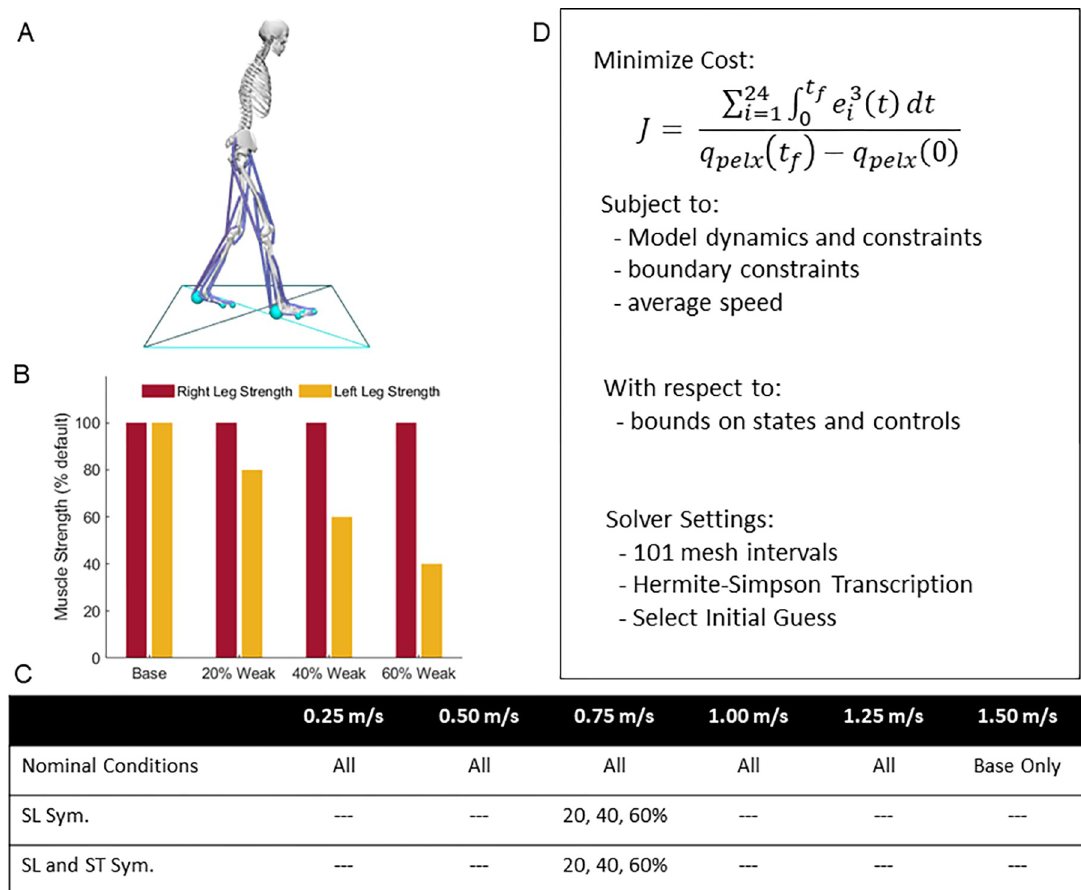
Fig 1. Summary of set up. A) Two-dimensional musculoskeletal model with 11 mechanical degrees-of-freedom and 24 muscle-tendon units [86]. Blue spheres represent foot-contact elements on the model with the blue box visually representing the floor. B) Maximum isometric muscle forces relative to base model for the 20%, 40% and 60% weak models, muscle strength was uniformly reduced on the left limb, C) Table showing the optimal control conditions for each speed: we used all four models for each of the speeds between 0.25 m/s and 1.25 m/s, and ran our second analysis at 0.75 m/s for the step length symmetry (SL Sym.) and step length and step time symmetry (SL and ST Sym.). D) Overview of optimization process in Moco, where the objective function (Eqs 1, 5, or 6 respectively from methods) and constraints (Eqs 2 and 3 from methods) for the problem are sent to the solver, with specified settings. Note that the objective function value seen here is for the nominal optimizations, see the methods for further details. The OpenSim image depicted is based on models available at simtk.org and the specific model and data shown here can be downloaded from https://simtk.org/projects/ post-stroke-sym. elastic elements [53]. The DeGrooteFregly2016Muscle model was used for this study since it is smooth and continuous everywhere; this is required for Moco which uses a gradient-based optimization approach to solve optimal control problems. In addition, it provides an implicit form of muscle-tendon dynamics, which is more computationally efficient and converges more reliably compared to the explicit form of muscle-tendon dynamics [53]. The foot-ground interactions were simulated using five contact spheres per foot, represented with smooth and continuous functions [54]. We used this musculoskeletal model with symmetrical strength for the base conditions, and then created three other models where the peak isometric strength of each muscle on the left limb was reduced from the base model by 20%, 40%, and 60% for the three hemiparetic conditions (Fig 1B and Table 1). This unilateral reduction in peak strength was intended to simulate the loss of force production capacity that commonly results from